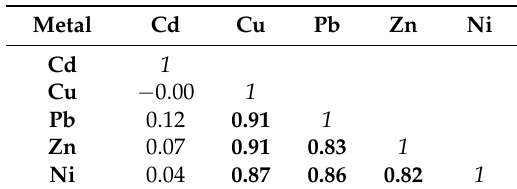
Table 6. Correlation table of the metal contents in sediments. Bold font indicates significant correlations ( p < 0.05). Bold font indicates significant correlations. The italics is just to distinguish the correlation between the variables